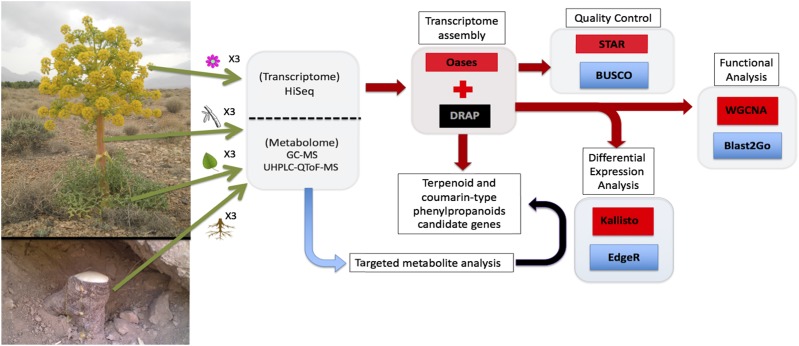
Workflow for transcriptome and metabolite analysis of different organs of F. assafoetida. Shown is a schematic overview of the transcriptomics analysis performed on different organs (flowers, leaves, stems, and roots) harvested from three wild F. assafoetida plants (green arrows) and used for transcriptome (red) and targeted metabolite analysis (blue). Black arrows highlight the correlation of de novo transcriptome and metabolite analysis to identify candidate genes with possible roles in terpenoid and coumarin-type phenylpropanoid metabolism.